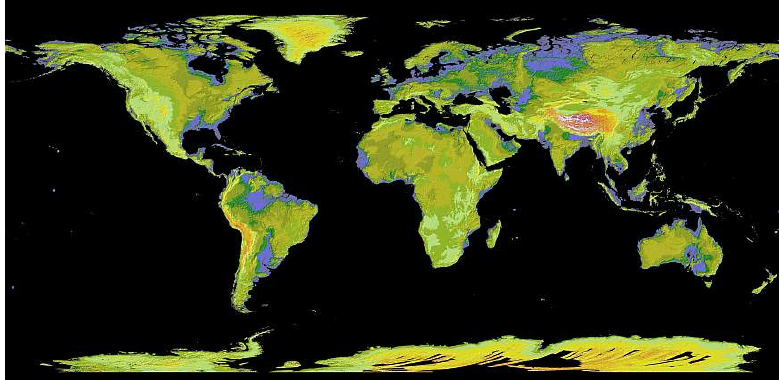
Figure 1. Colorized, shaded relief depiction of the Advanced Spaceborne Thermal Emission and Reflection Radiometer (ASTER) global digital elevation model Version 1. Ocean is zero elevation, and black. Color scale from (with increasing elevation) purple, blue, green, olive, light green, chartreuse, yellow, orange, dark red, to white. Note the holes in northern Asia, where persistent snow and clouds limited the acquisition of usable scenes.